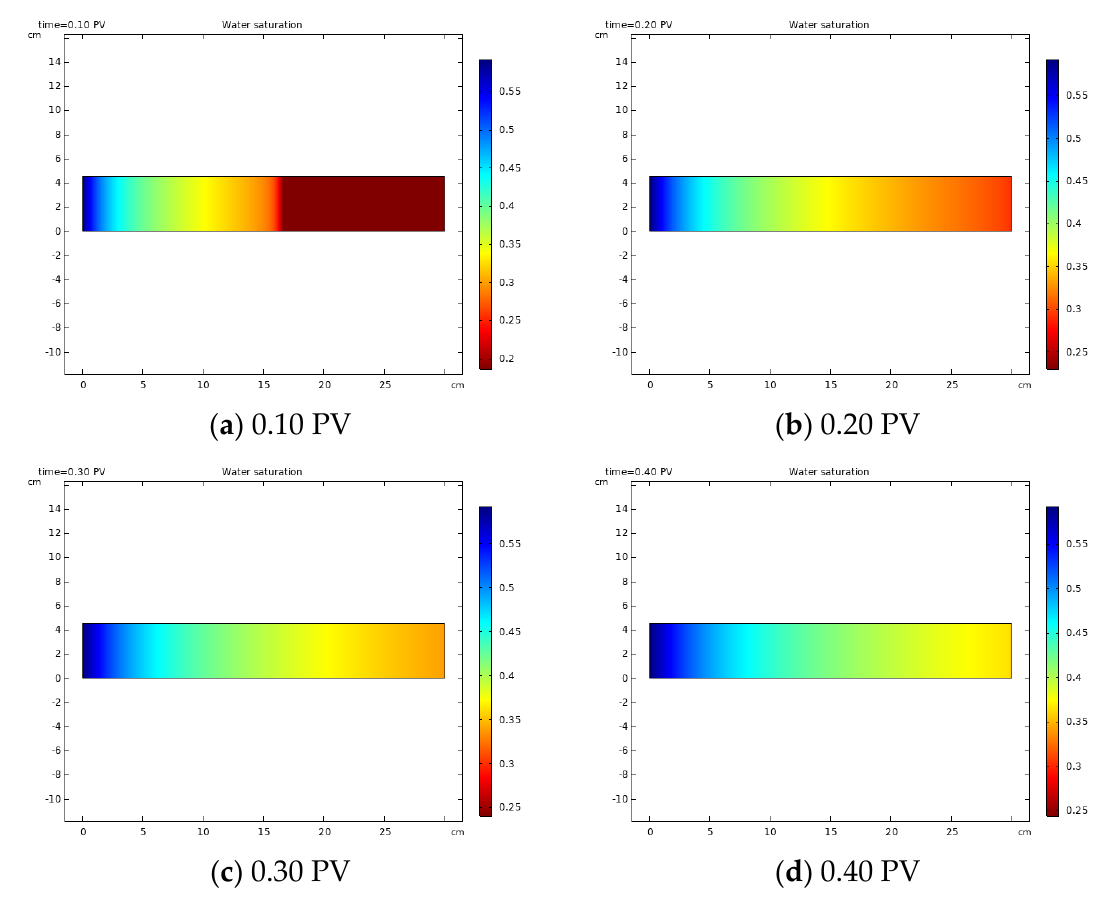
Figure 10. Water saturation under different injection time of water flooding.